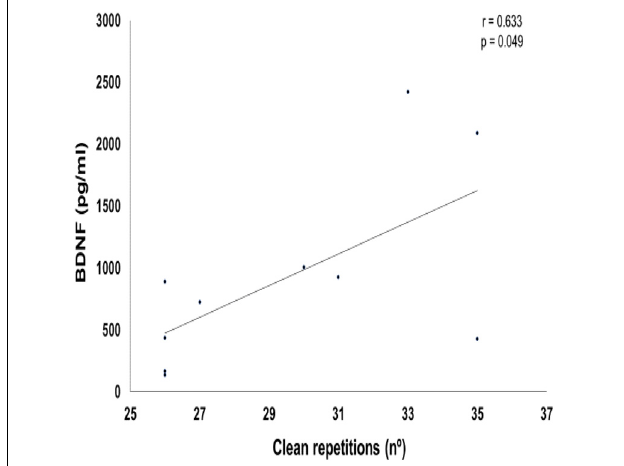
FIGURE 7 | Graphic of Pearson correlation between brain-derived neurotrophic factor (BDNF) and clean exercise